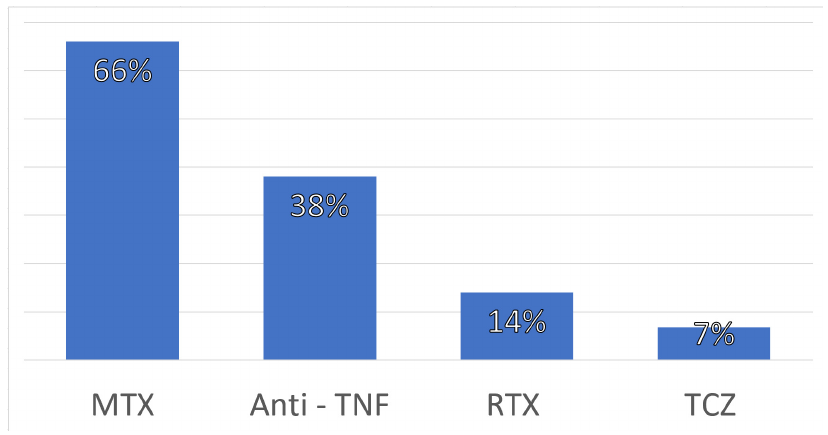
Figure 1. Baseline treatments in SAD patients and vaccinated with sublingual polybacterial vaccines (N 0 41). MTX: Methotrexate. Anti-TNF: anti-tumor necrosis factor. RTX: Rituximab. TCZ: Tocilizumab.